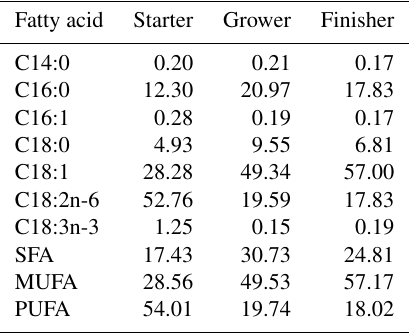
Table 2. Fatty acid composition (% of total FAME) of the